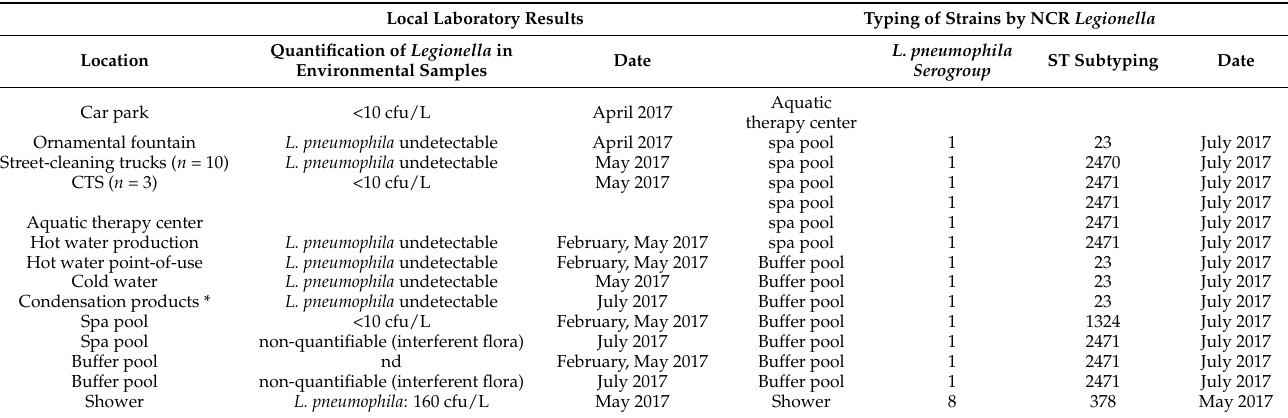
Table 2. Environmental microbiology results, outbreak of Legionnaires’ disease, district in the city of Montpellier, December 2016 to July